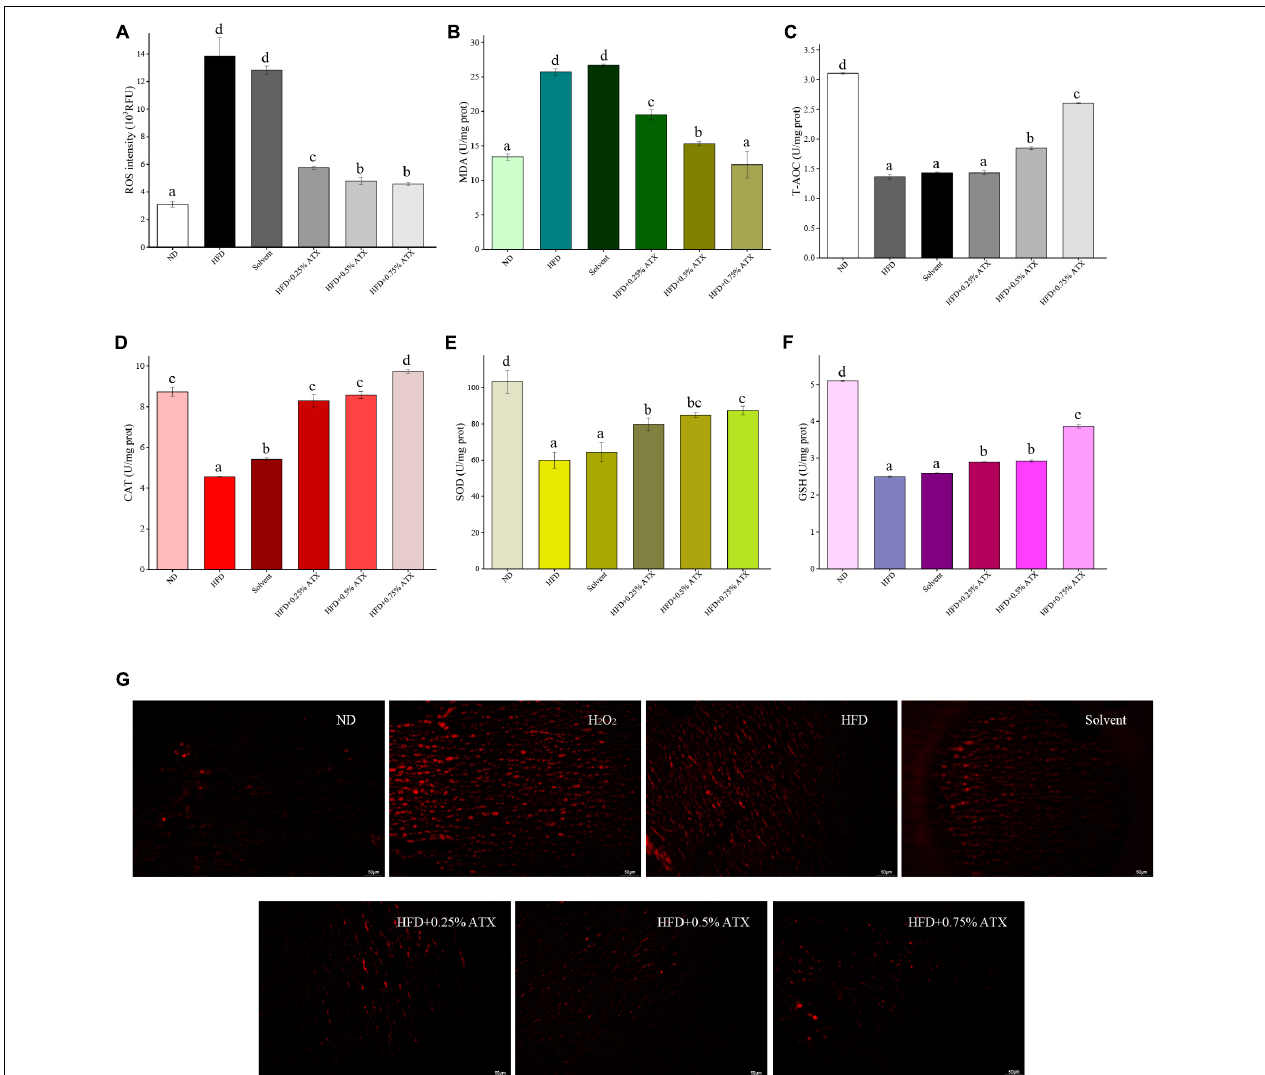
FIGURE 2 | Evaluation of liver oxidation resistance in HFD-induced mice liver tissues. The levels of ROS intensity (A) , MDA (B) , T-AOC (C) , CAT (D) , SOD (E) , and GSH (F) are illustrated in the panel. Values are expressed as mean ± SD of triplicate ( n = 6). The different letters (a–d) indicate significant differences ( P < 0.05) according to Duncan’s multiple range test in ANOVA. (G) Qualitative detection of ROS by the DHE probe; the ROS-positive cells emitted bright red fluorescence; H 2 O 2 : as double positive control, and tissues were incubated with 3% H 2 O 2